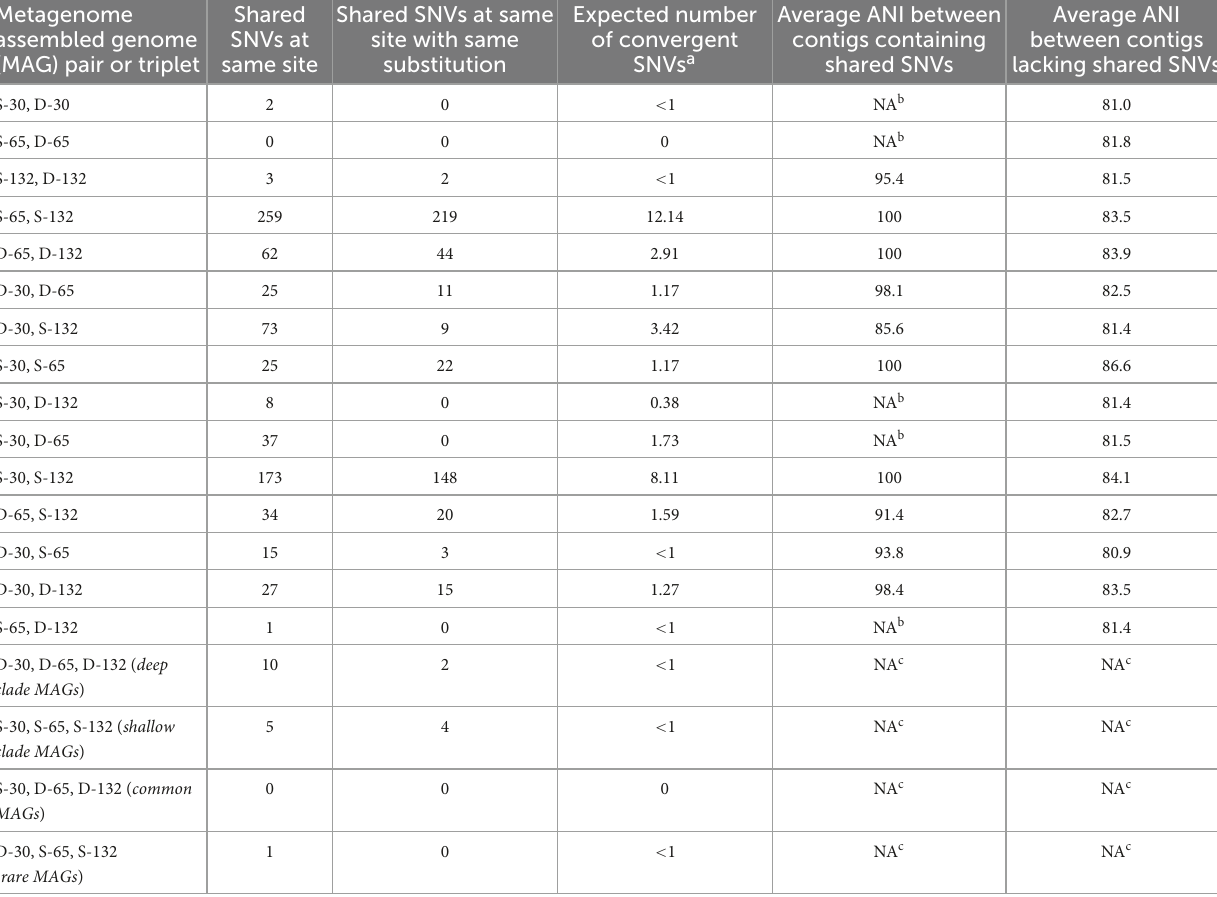
TABLE 3 Single nucleotide variants (SNVs) identified between the specified pair or triplet of metagenome assembled genomes (MAGs). Metagenome assembled genome (MAG) pair or triplet